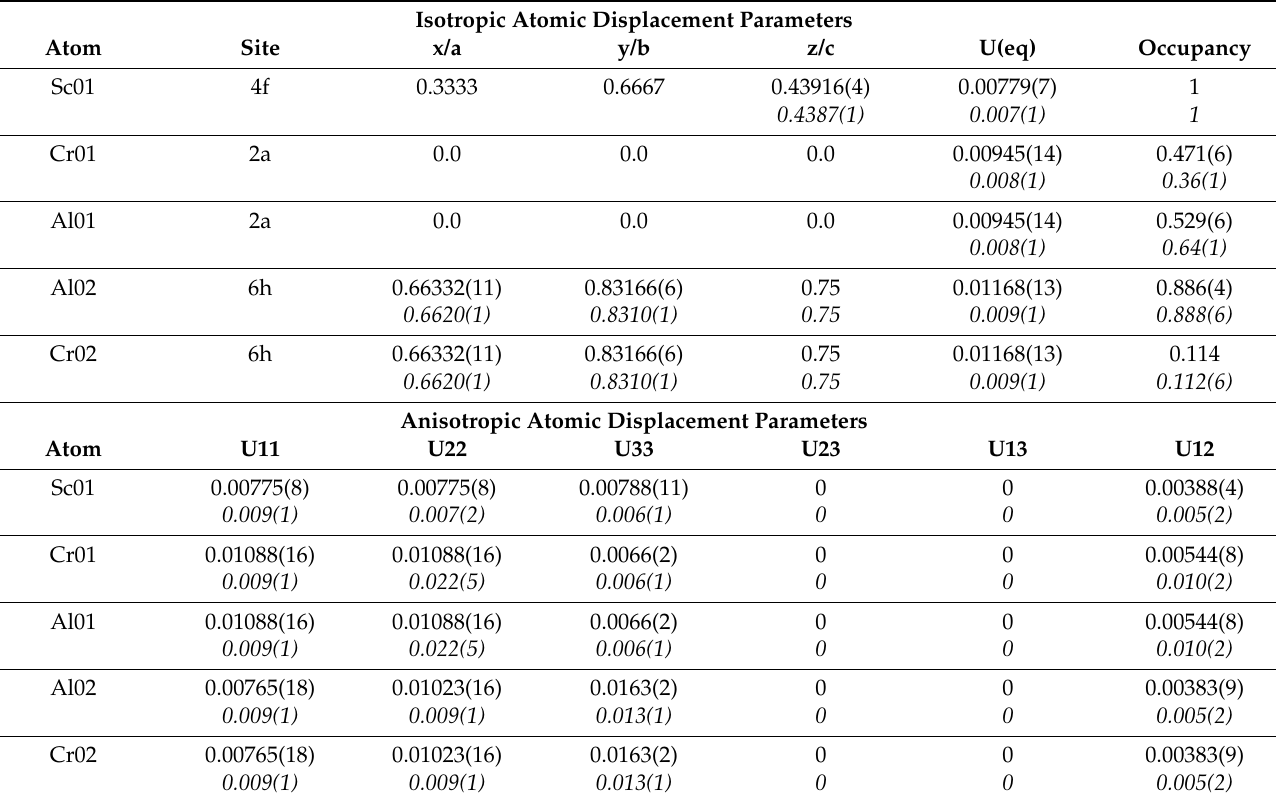
Table 5. Atomic coordinates and isotropic and anisotropic atomic displacement parameters (Å) that were obtained from the single-crystal data (the second lines in italic correspond to the values that were obtained from the powder